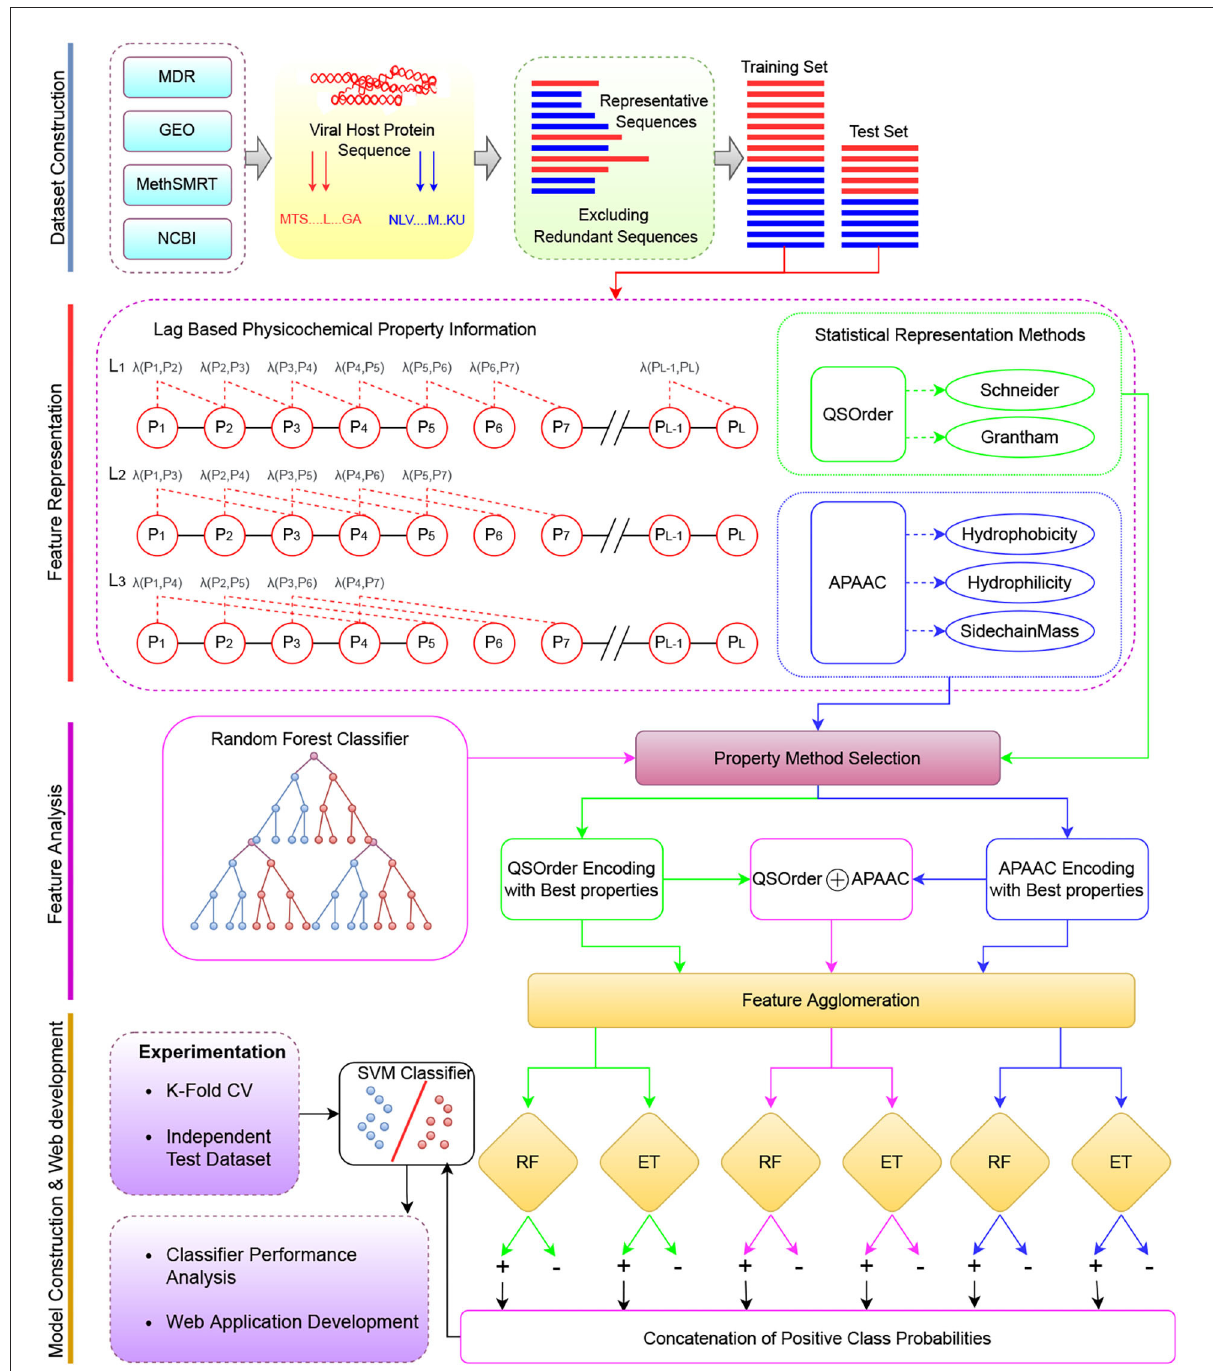
FIGURE1 The overall working paradigm of the proposed VHPPIs predictor. Dataset Construction To begin with, different datasets are collected from existing studies based on VHPPIs from several databases such as HPID, Intact, and VirusMentha. Feature Representation Obtained protein sequences are encoded on the basis of two physicochemical properties based protein sequence encoders i.e., QS order and APAAC. Feature Analyzes Appropriate physicochemical properties are selected for the APAAC and QS order on the basis of feature analyzes. Model Construction the VHPPIs predictor is an SVM model formed on the basis of probabilistic vectors obtained from the RF and ET classifiers. Finally, a web server is established for fast, and easy on-go analyzes of